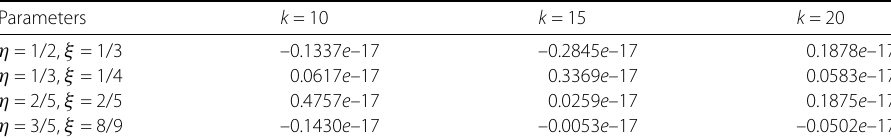
Table 4 Absolute error in boundary conditions of v ( t ) of Example 6.2 using different choice of parameters